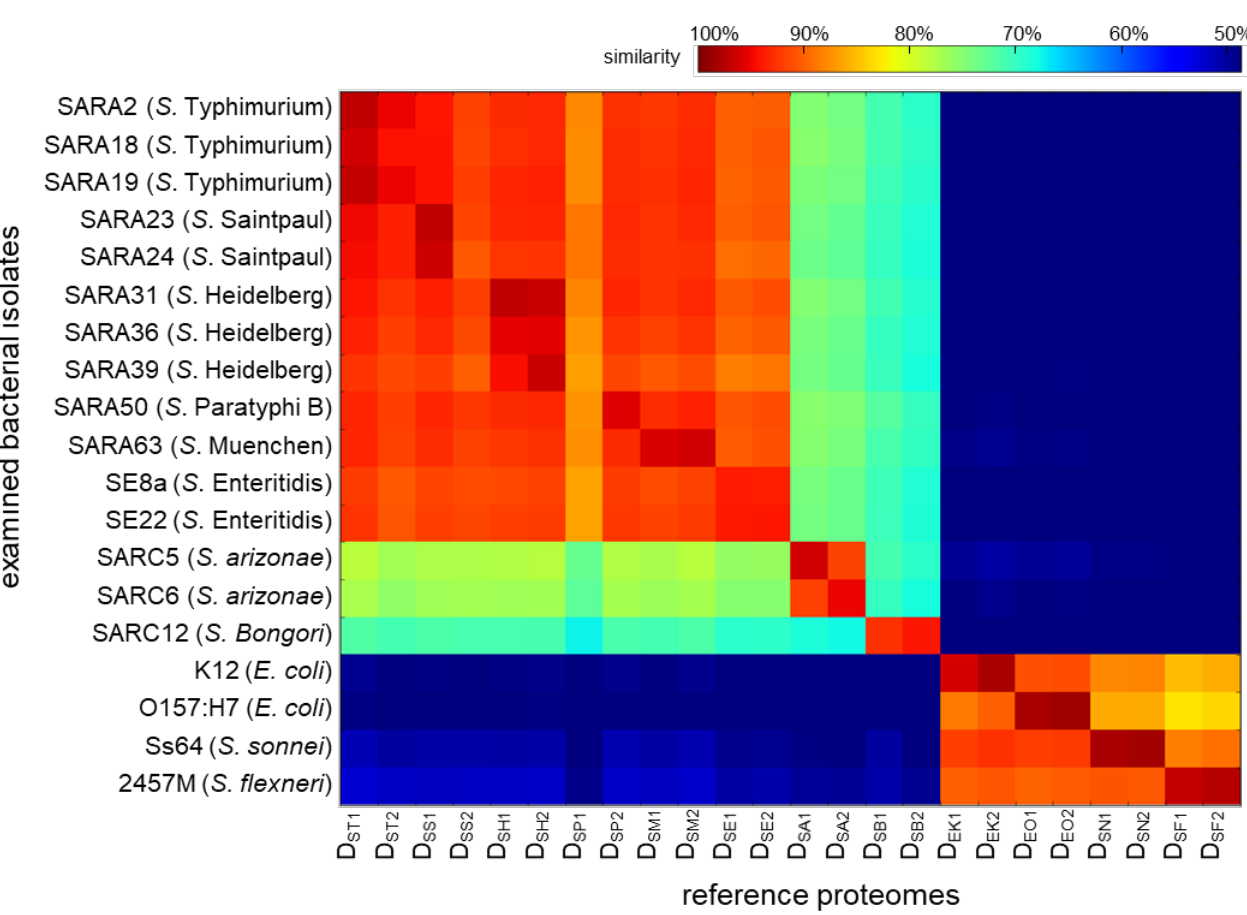
Figure 4. Heatmap representing the degree of similarity in sequences between proteomic data and reference proteomes, with the similarity decreasing from red (100%) to blue (48%). The match to other foodborne bacteria is less than 40% and not shown here. The detailed data are provided in Table S2.